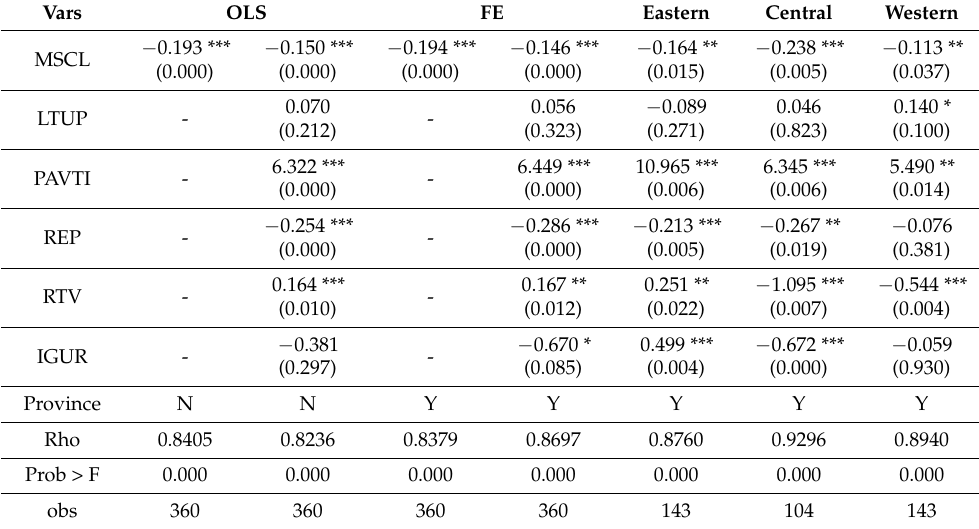
Table 2. The estimation results of the econometric model.